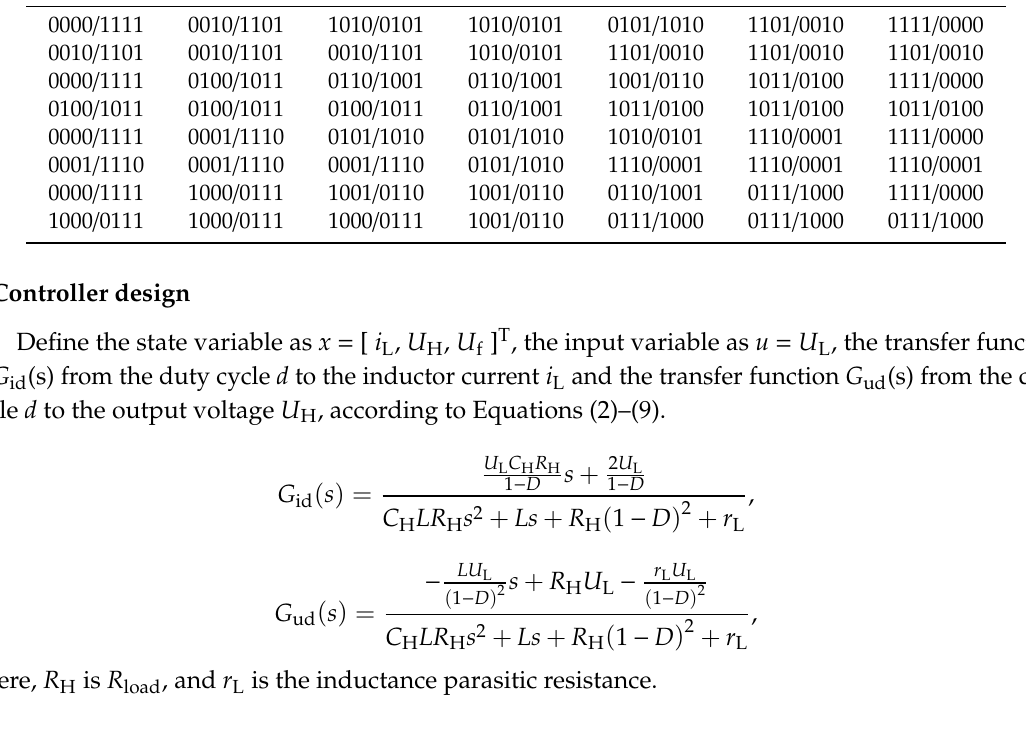
Table 3. Four arms mixed modulation coding.